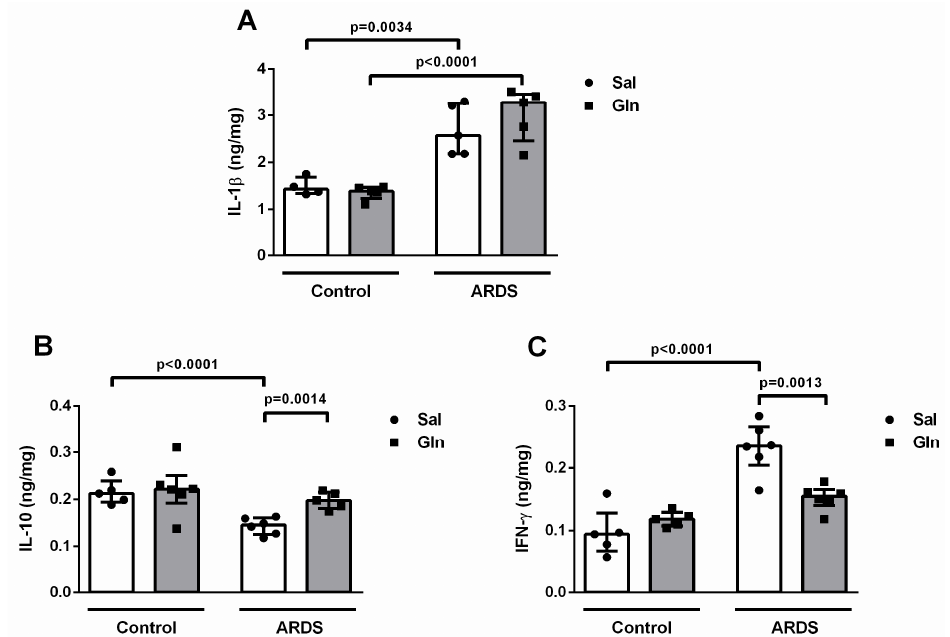
Figure 3. Glutamine in a mouse model of pulmonary ARDS differentially modulated cytokines in lung tissue. The cytokines interleukin (IL)-1 β ( A ), IL-10 ( B ), and interferon (IFN)- γ ( C ) were evaluated by specific ELISA in the left lung of Control-Sal, Control-Gln, ARDS-Sal, and ARDS-Gln BALB/c mice ( n = 6/each). Lung tissue samples were removed after collection of lung mechanics data 24 h after LPS instillation. The total cytokine content was normalized to total protein content. Values expressed as median (interquartile range) of six animals in each group. Symbols represent individual animals. Experiments were performed in triplicate. The data shown are from a single representative experiment.